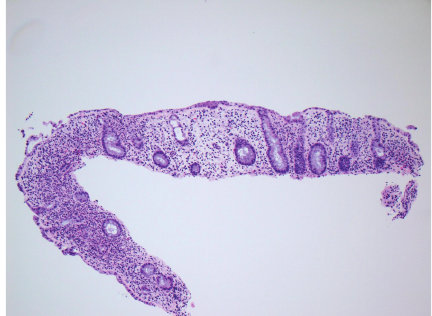
Figure 1: The colonic biopsies show crypt distortion with angula- tion, lamina propria edema, and increased lamina propria inflam- mation (H&E stain,